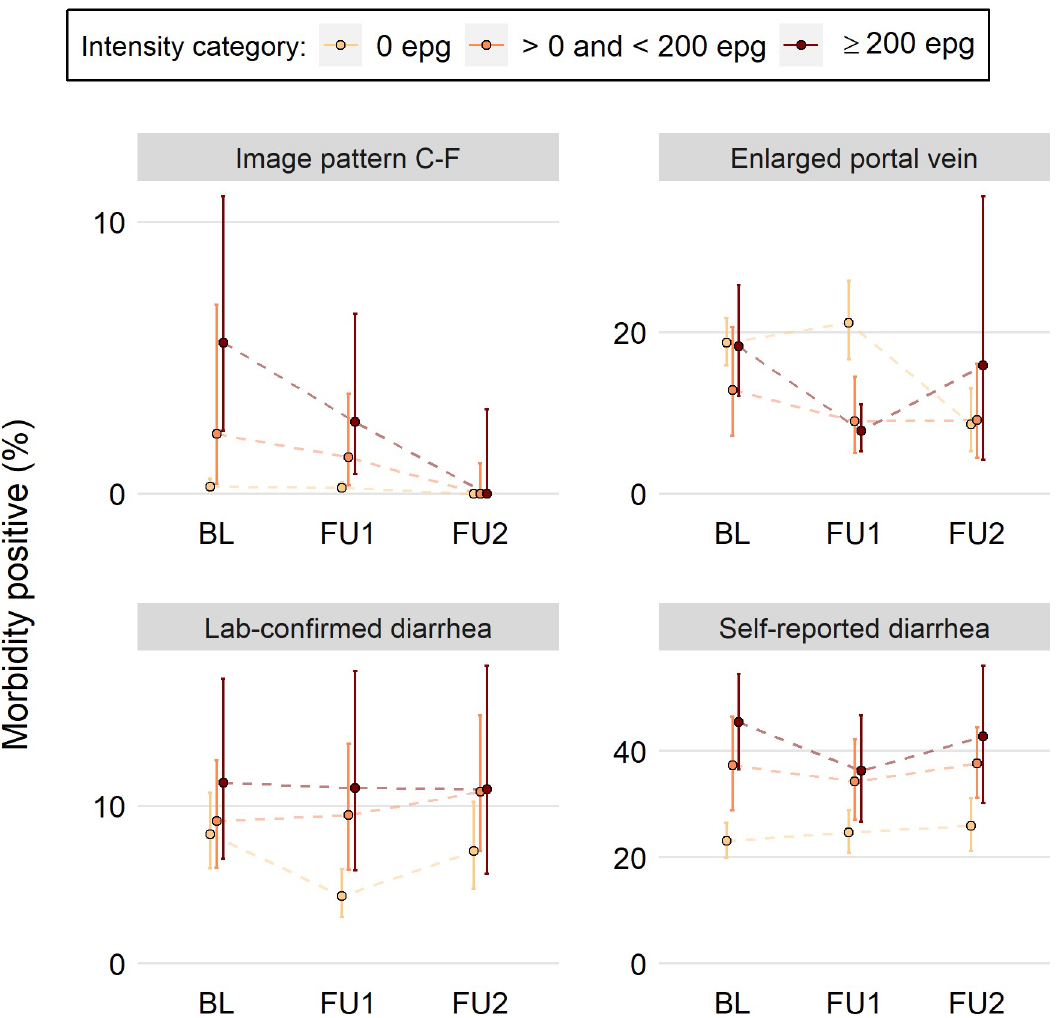
Fig 4. Modification of Fig 3 where participants’ Schistosoma mansoni intensity is split into three categories: 0 EPG, 1–199 EPG, and � 200 EPG. See Fig 3 description for more details. Data are from three surveys (baseline, BL; follow-up 1, FU1; follow-up 2,